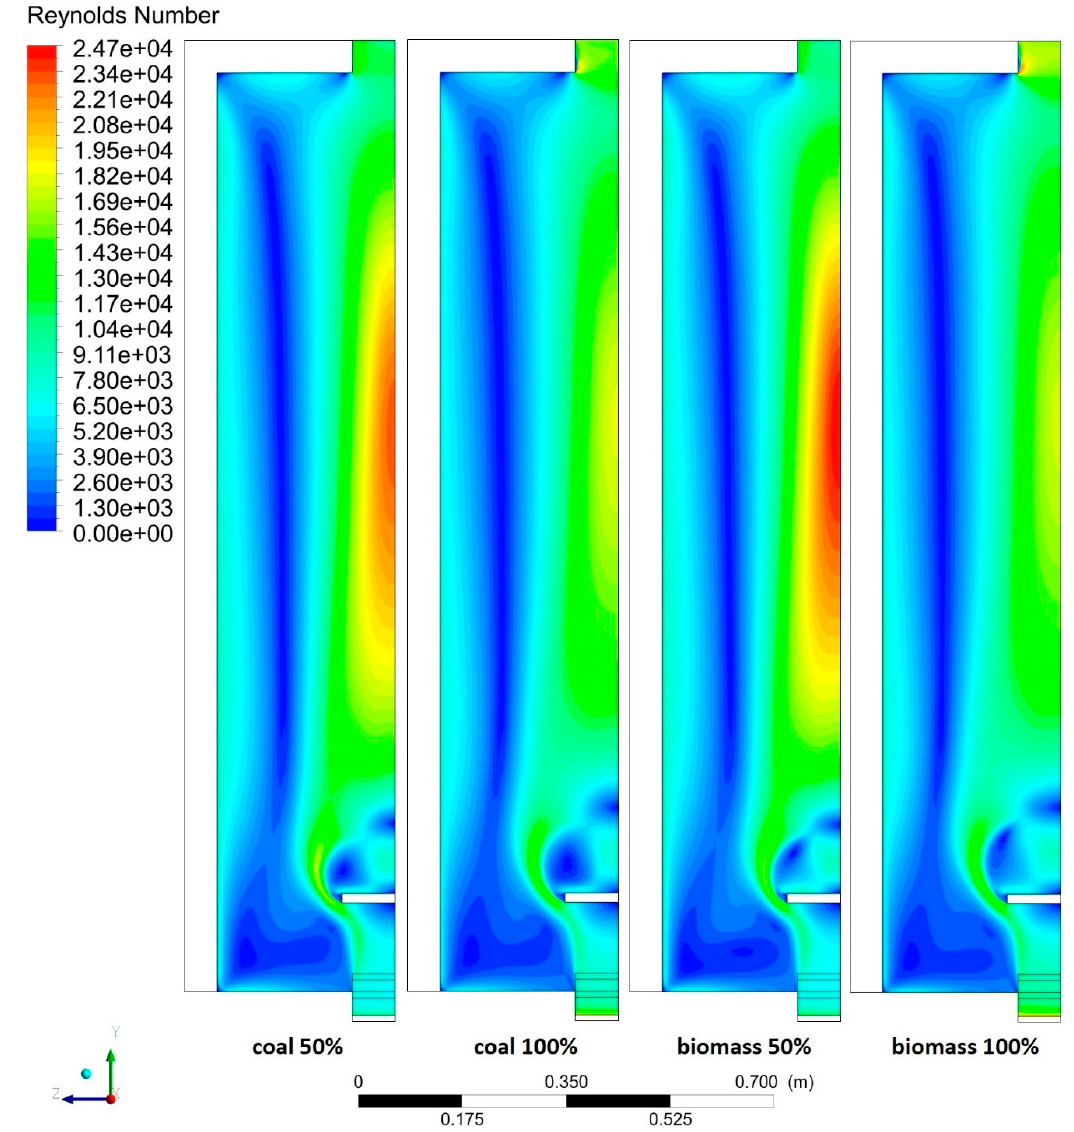
Figure 9. Reynolds number distribution obtained for each of the analyzed cases.